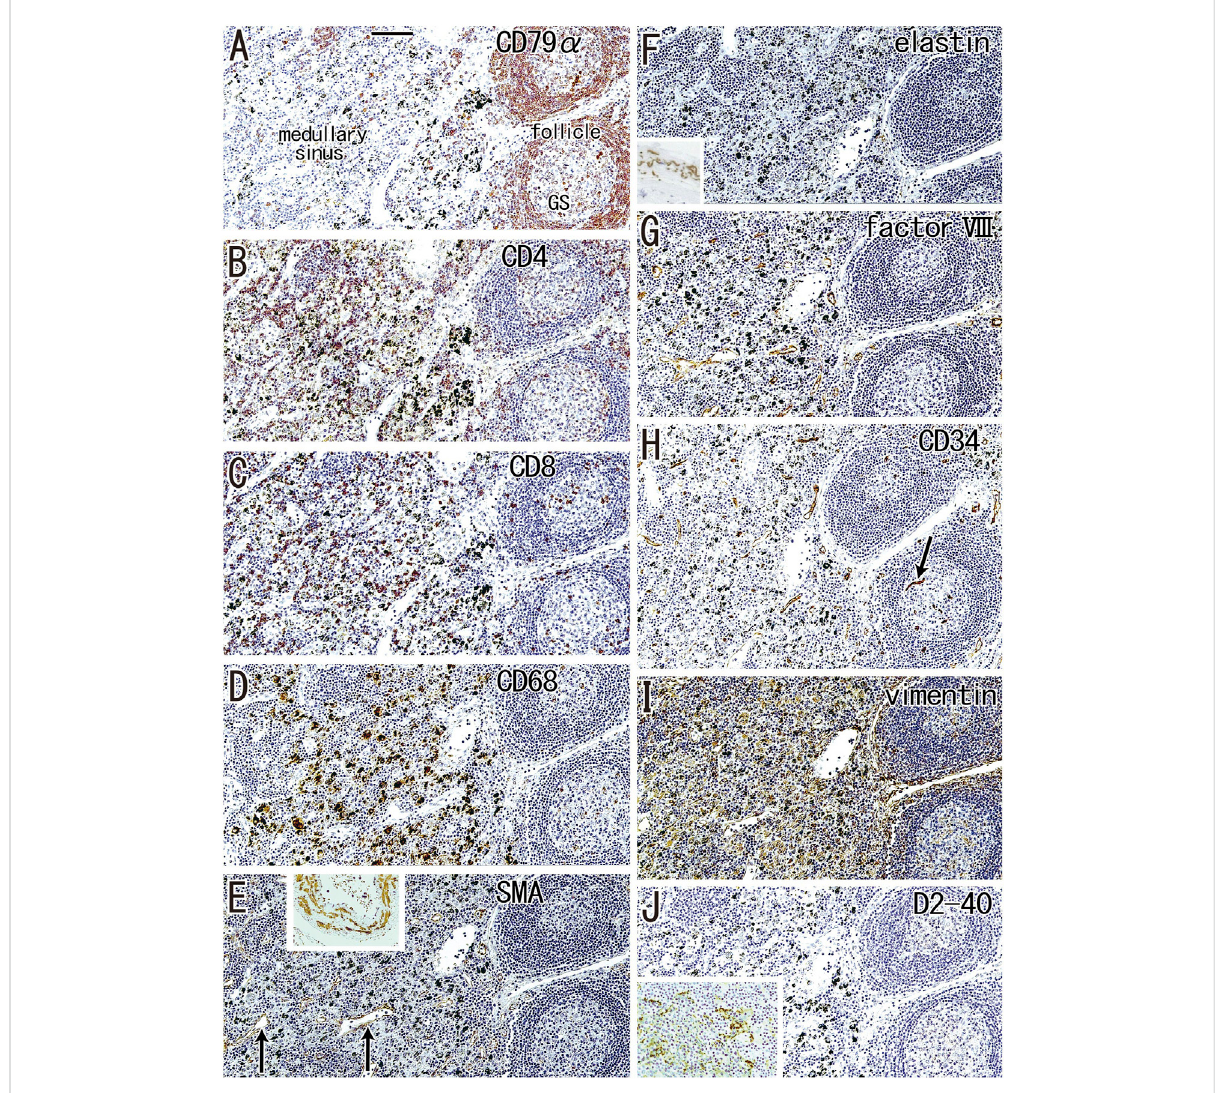
FIGURE 3 Immunohistochemistry of the lymph follicle and medullary sinus: the usual morphologies. An interlobar node removed from a 64-years-old woman (non-smoker). The DAB reaction made the positive cells brown. CD79a-positive B lymphocytes surrounds germinal center (GS) in (A) . The medullary sinus contains abundant CD4 − or CD8-positive T lymphocytes (B,C) . In the medullary sinus, almost all of CD68-positive macrophages carry carbon particles [anthracotic macrophages; (D) ]. Endothelium of thin arteries[arrows in (E) ] is positive for smooth muscle actin [SMA; (E) ]. An insert at the upper margin of (E) shows a positive control of the present SMA antibody (artery found in the same section). Factor VIII-positive vessels are absent in germinal center (G) in contrast to CD34-positive vessel [arrow in (H) ]. Vimentin reactivity (I) appears to be present in both macrophagesandsomestromalcellsinthemedullarycells.Noreactivityisseenforeitherelastin (F) orD2-40[podoplanin; (J) ].Aninsertatthelower angleof (F) exhibitsthepositivecontrolofelastinimmunostaining(anarterialwalloutsideofthenode).Aninsertatthelowerangleof (J) displaysD2- 40-positivefolliculardendriticcellsinanotherspecimen(a70-years-oldman,smoker).Allpanelswerepreparedatthesamemagni fi cation[scalebar in (A) , 0.1